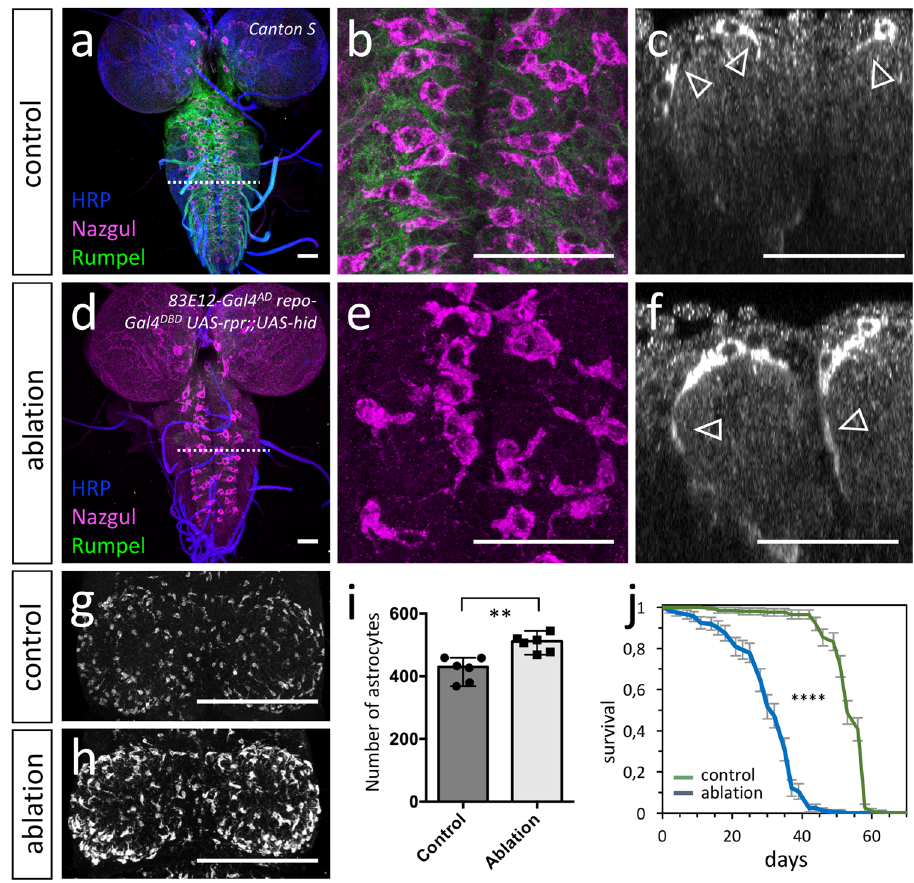
Fig. 4 Ablation of ensheathing glia causes compensatory growth and increased proliferation of astrocyte-like cells. Representative images are shown. a – f Third instar larval brains stained for Rumpel (green, expressed by ensheathing glia), Nazgul (magenta, expressed by astrocyte-like cells) and HRP (blue, neuronal membrane marker). a Maximum projection of a confocal stack of a control larval CNS. The dashed line indicates the position of the orthogonal view shown in ( c ). b Dorsal view of a control ventral nerve cord. Note the regular positioning of the astrocyte-like cells (magenta). c Orthogonal section of astrocyte-like cells which are labelled using anti-Nazgul staining (white, arrowheads point to short protrusions). d , e Upon ablation of the ensheathing glia [ UAS-rpr; 83E12-Gal4 AD ; repo-Gal4 DBD , UAS-hid ], Rumpel expression is greatly reduced. The dashed line indicates the position of the orthogonal view shown in ( f ). e Dorsal view of a larval ventral nerve cord following ensheathing glia ablation. The position and the morphology of the astrocyte-like cells appears disorganized. f Orthogonal section. Note, that astrocyte-like glial cells develop long cell processes that appear to encase the entire neuropil in the absence of ensheathing glia (arrowheads). g Dorsal view on a thoracic neuromere of an adult control fl y. h Thoracic neuromere of an adult fl y lacking ensheathing glial cells. The number of astrocyte-like cells increases. i Quanti fi cation of the number of astrocyte-like cells in the ventral nerve cord of adult fl ies ( n = 6 brains, ** p = 0.0018, unpaired t-test, two-tailed, standard deviation is indicated). j Upon ablation of the ensheathing glia, longevity is reduced ( n = 200 mated females, **** p = 4.67365E-83, Log-rank test, two tailed, standard deviation is indicated). Scale bars are: a – f 50 µ m, g , h 100 µ m. Source data are provided as a Source Data fi